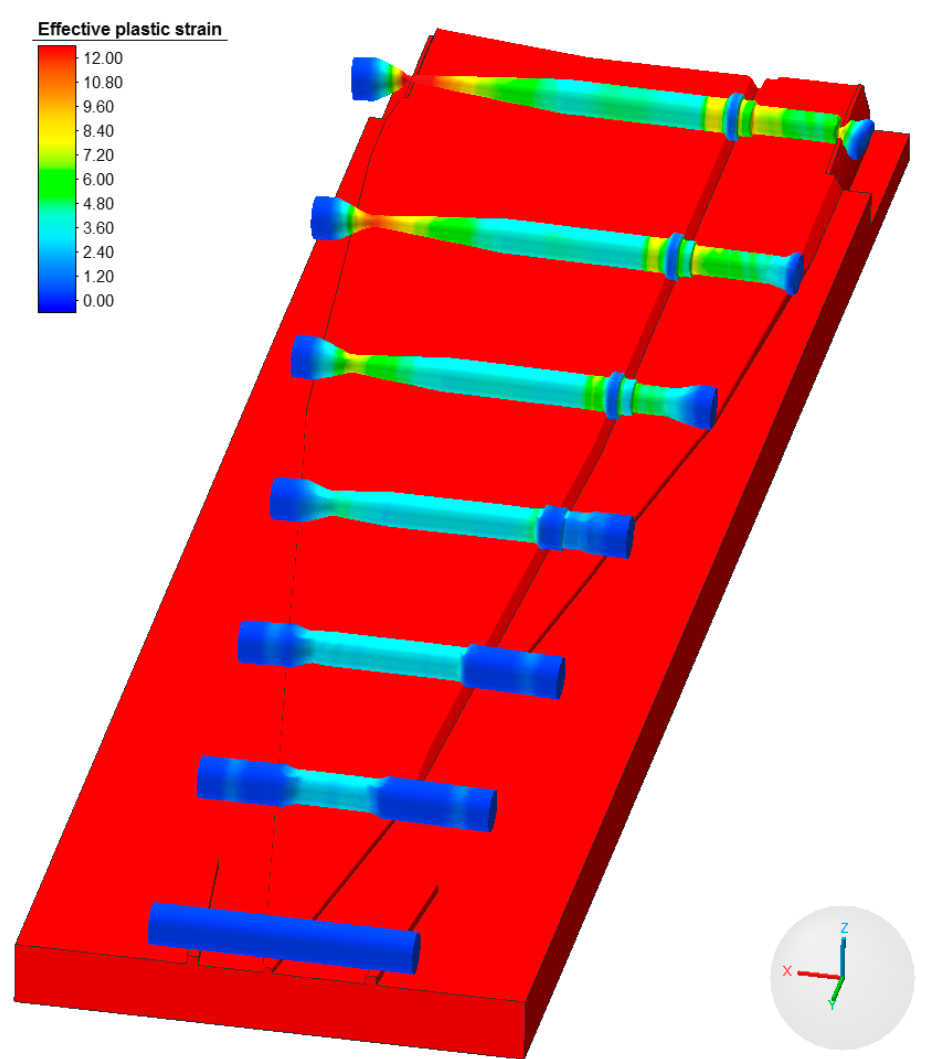
Figure 16. Progression of the shape of the harrow tooth preform during the rolling process with the distribution of effective strain.